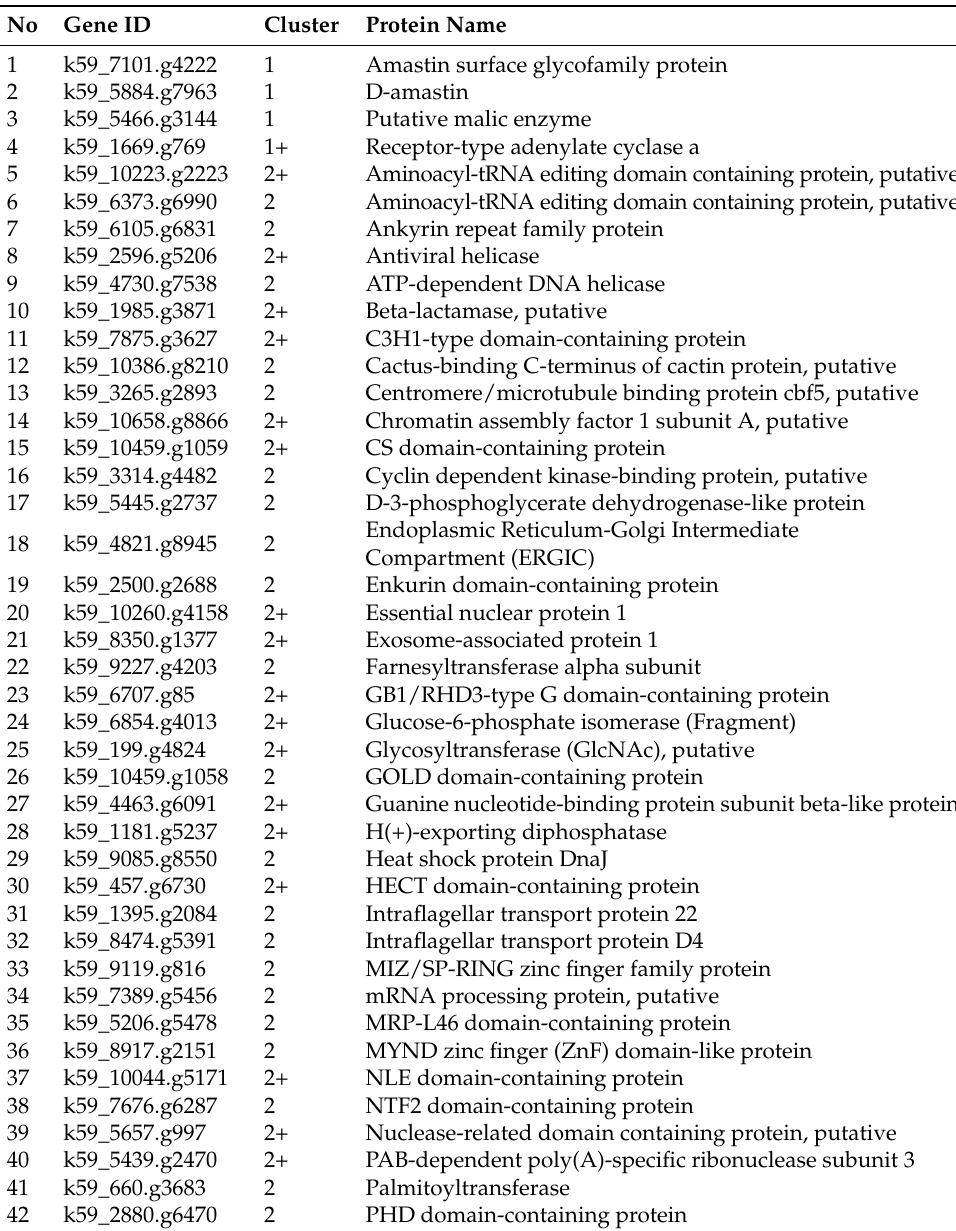
Table 4. Unique proteins present in the proteomes of L. orientalis isolate PCM2 and L. martiniquensis isolate PCM3. The “+” in the cluster column represents the presence of the protein in L. orientalis isolate